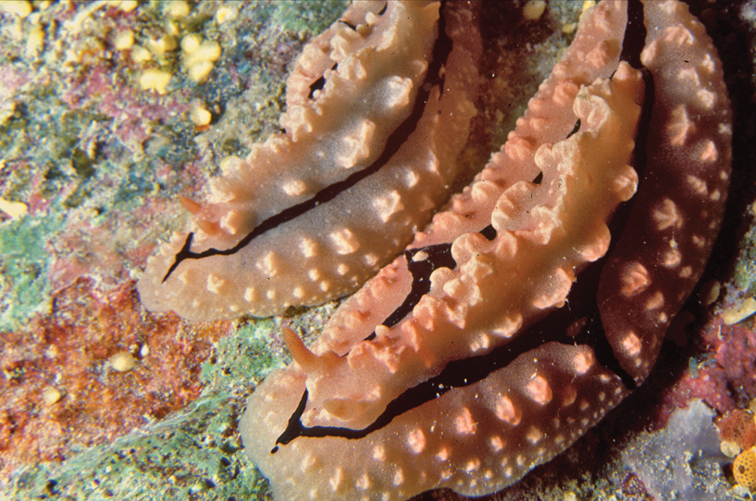
Phyllidiopsis shireenae, 60 & 95 mm, Maldives, photo: H Voigtmann.